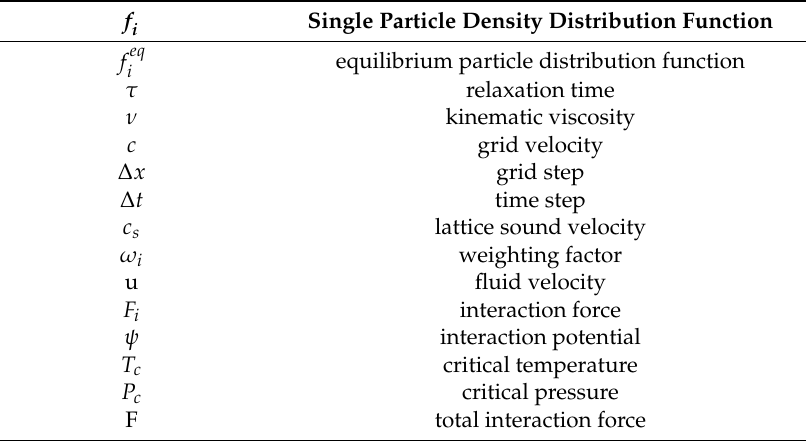
Table A1. All variables with